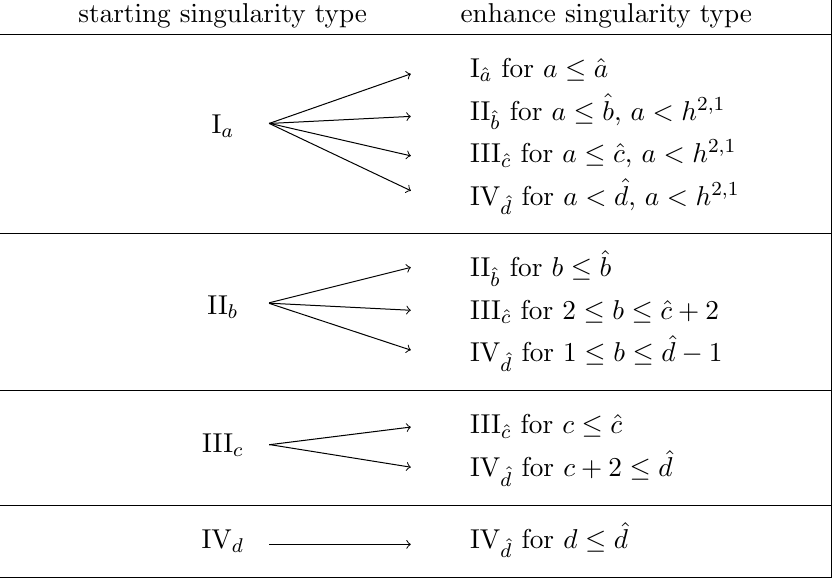
Table 3 . List of all allowed enhancements obtained by imposing consistency of the polarization conditions (2.45), (2.46). These have been shown in [25] and the details of their derivation are given in appendix